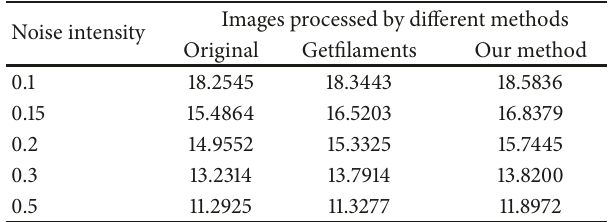
Table 1: PSNR comparison of images processed using different